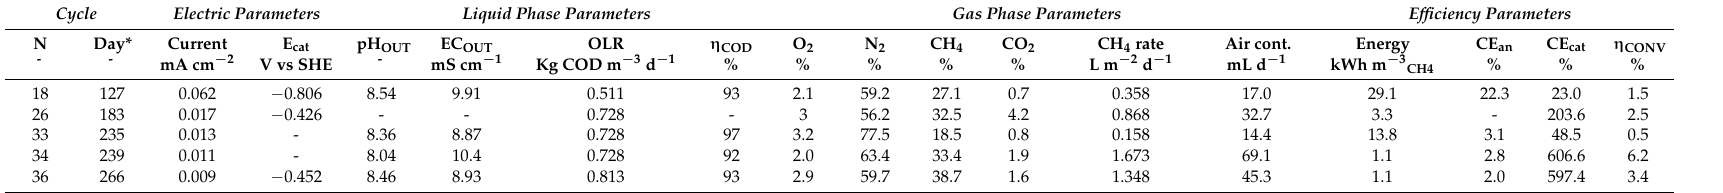
Table A8. Selection of five cycles for BES 4, operated at constant 0.7 V voltage with synthetic medium.